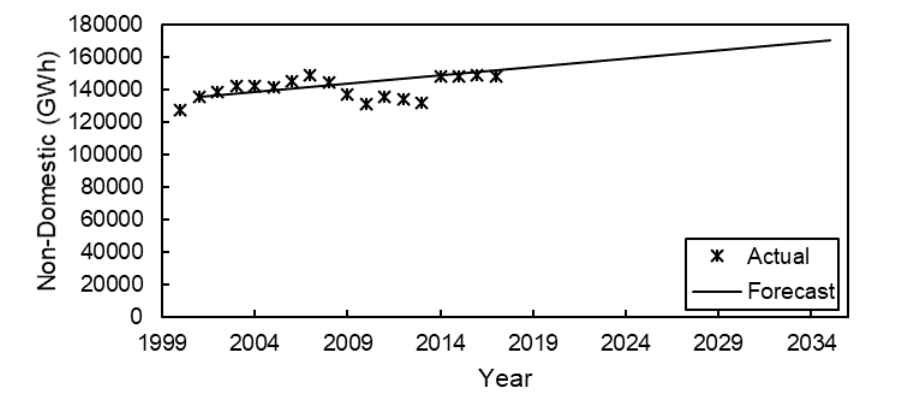
Figure 6: Electricity demand forecasting electricity for non-domestic consumers (standard error = 5.8 × 10 3